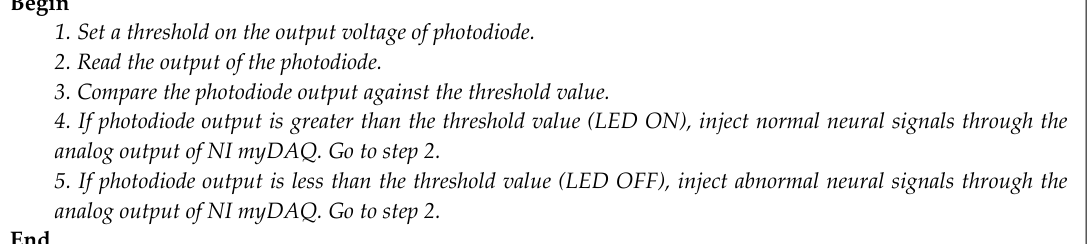
Figure 12. Pseudo-code for LabVIEW program.